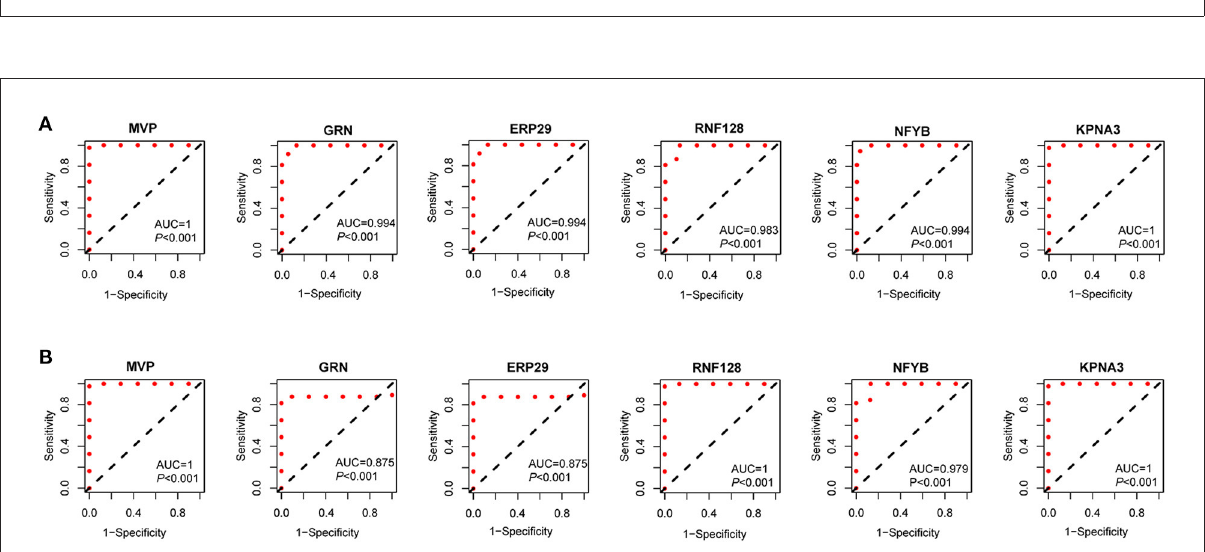
FIGURE6 Diagnostic efficiency of the seven key genes. (A) The ROC curves of the key genes in the GSE3307. (B) The ROC curves of the key genes in the